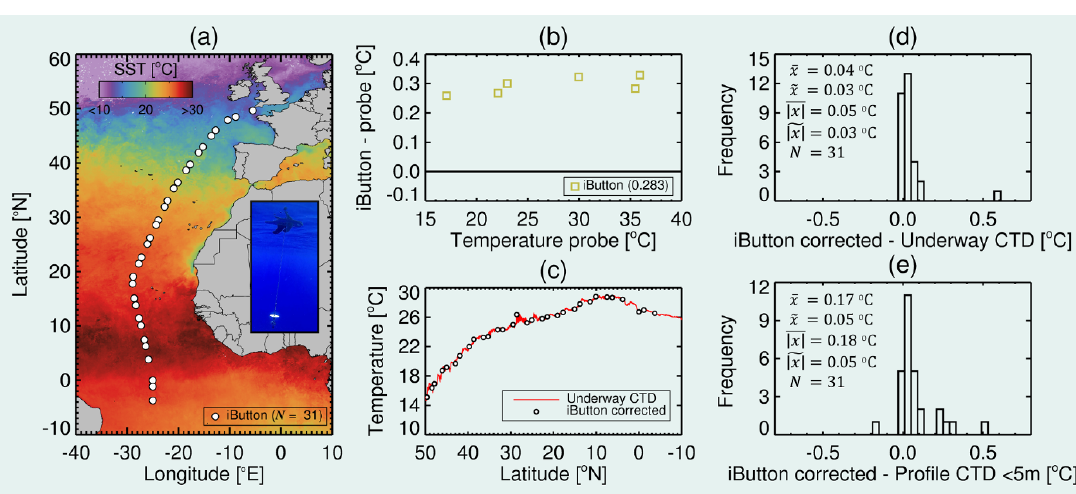
Figure 10. Evaluating the accuracy of water temperature measurements from an iButton attached to the mini-Secchi disk. ( a ) Deployments locations of the Small Oceanographic floating Device (SOD, see photo) with iButton and mini-Secchi disk on AMT28, overlain onto a Sea Surface Temperature (SST) monthly composite of October 2018 from the MODIS-Aqua satellite [61]. ( b ) Results from the comparison between the housed iButton and the NIST-traceable probe at different temperatures in a recirculating water bath. The value 0.283 represents median difference in temperature ( ◦ C). ( c ) Along-track SST from the underway CTD system with the iButton data (corrected following removal of systematic difference of 0.283 ◦ C) overlain. ( d ) Histogram of the water temperature differences between the underway CTD and iButton on the mini-Secchi disk. ( e ) Histogram of the water temperature differences between the profiler CTD in the top 5m (upcast) and the iButton on the mini-Secchi disk. Two outliers are not shown on the graph (1.19 and 1.72 ◦ C). ¯ x is the average difference, ˜ x is the median difference, ¯ | x | is the average absolute difference, ˜ | x | is the median absolute difference and N is the number of